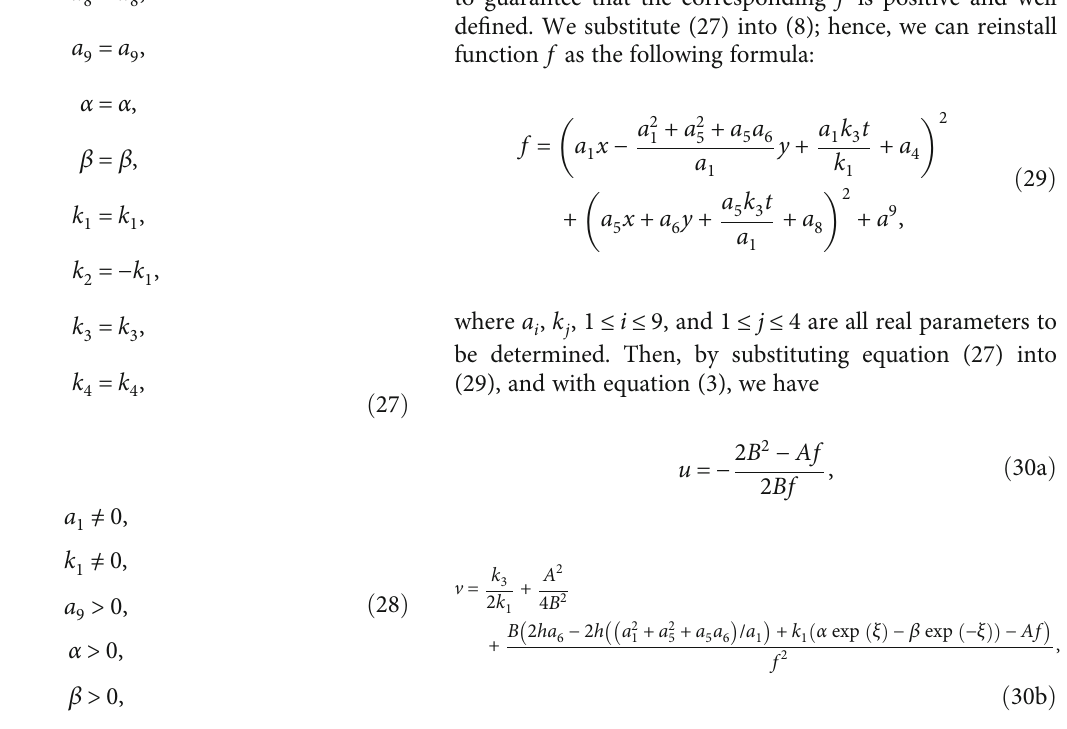
Figure 4: Pro fi les of the solution v via (30b) with a 3-dimensional plot with the time t = 0 ; (b – d) the corresponding density plots with di ff erent